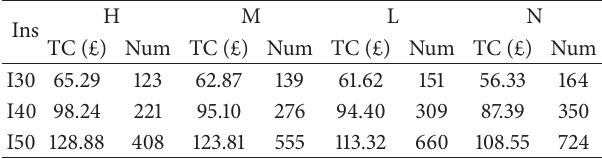
Table 4: Comparison with HE and MIP.